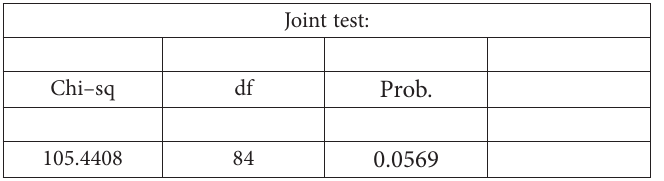
Table A5. VEC residual heteroskedasticity tests (source: authors’ calculations) Sample: 1995:1 2015:4